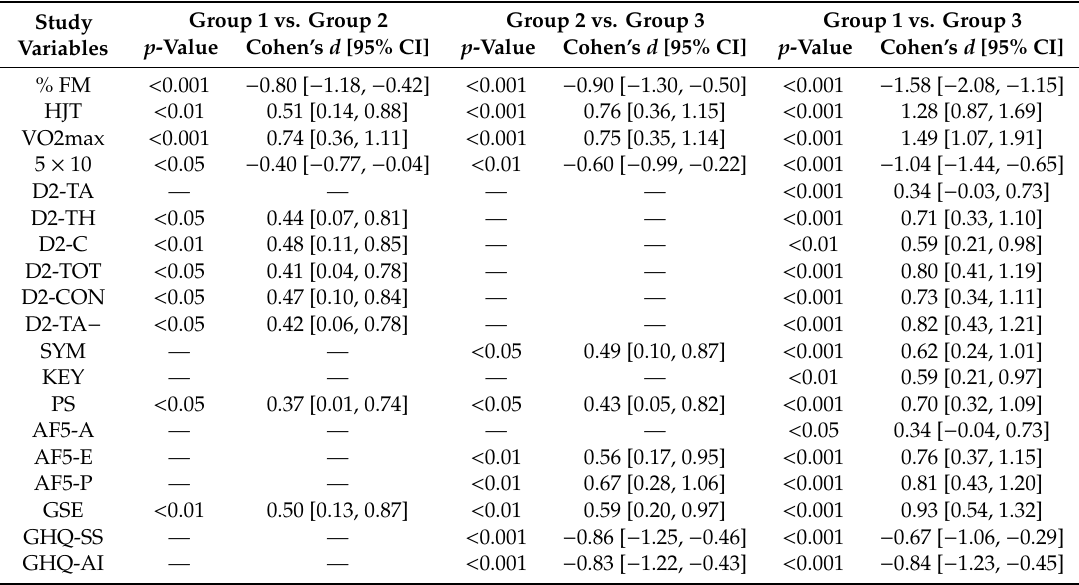
Table 3. Di ff erences among groups for each